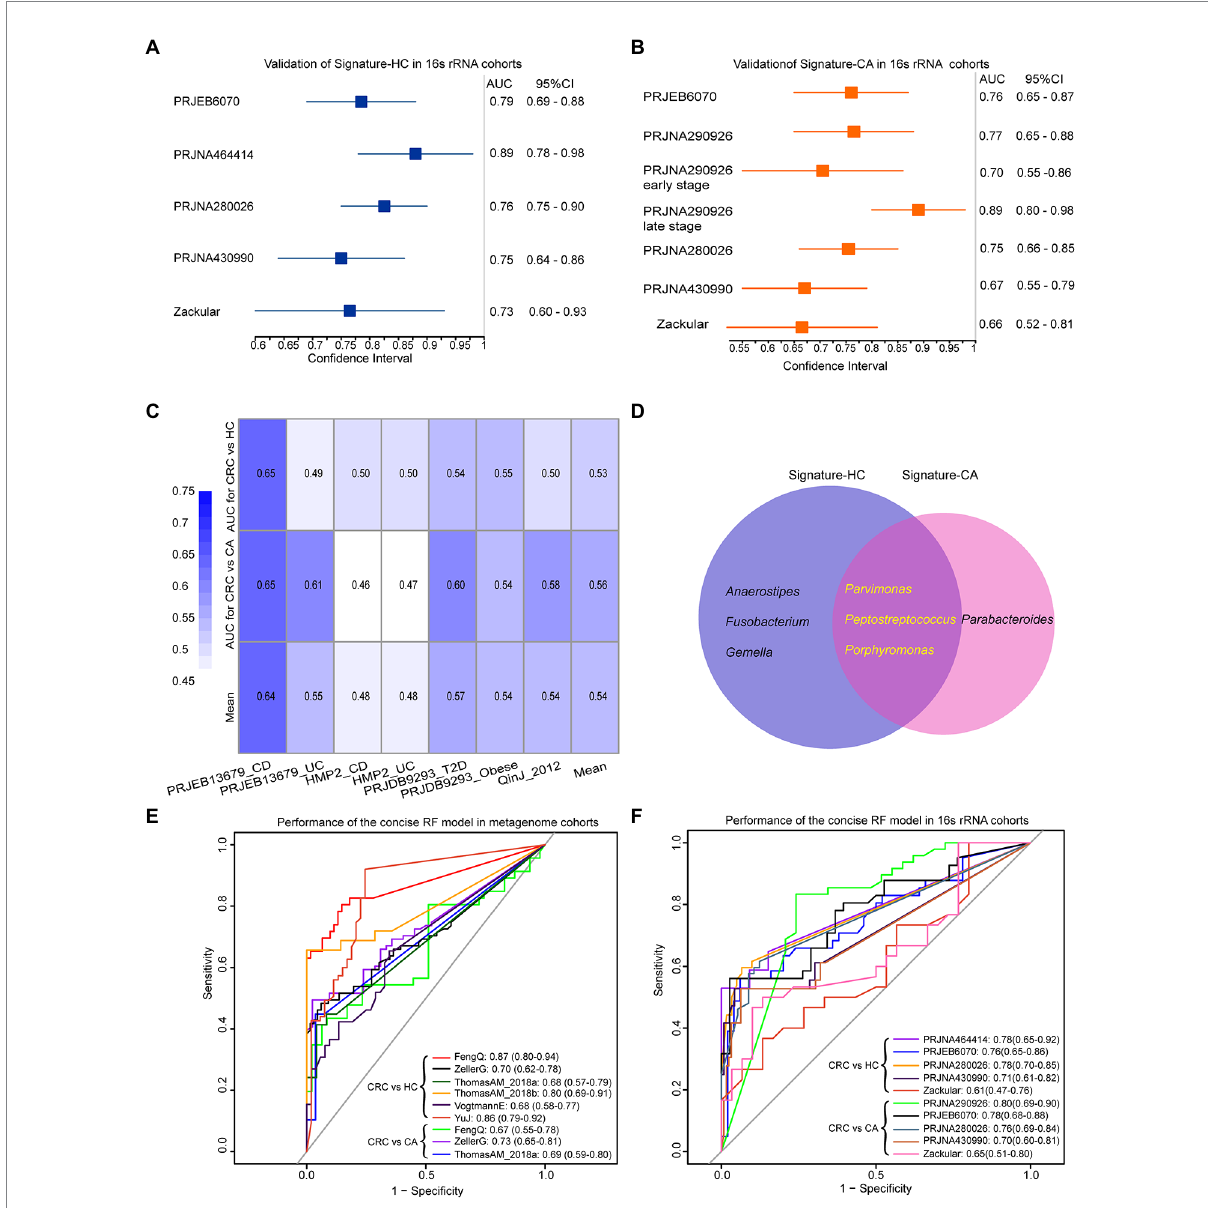
FIGURE 6 The performances of signature-HC and signature-CA across 16S rRNA gene sequencing data and three common genera shared by signature-HC and signature-CA. Performance of the signature-HC (A) and signature-CA (B) in six independent 16S rRNA gene sequencing datasets. (C) Performance of the signature-HC and signature-CA in other metabolism diseases. (D) Venn diagram for signature-HC and signature-CA. Performances of three overlapping genera in six metagenomic cohorts (E) and six 16S rRNA gene sequencing cohorts (F)